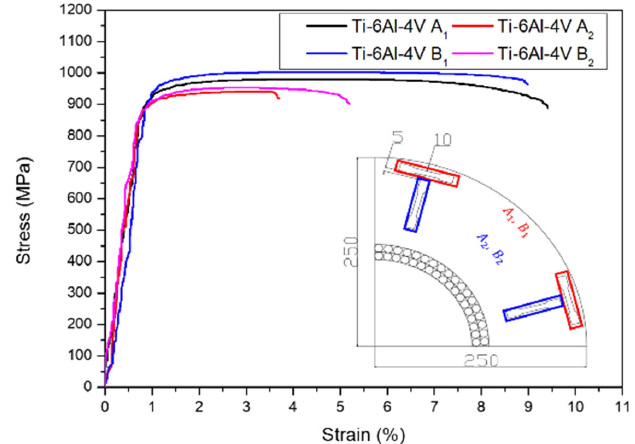
Figure 4. Tensile stress–strain curves circumferential and central directions of as ‐ received Ti ‐ 6Al ‐ 4V alloy.